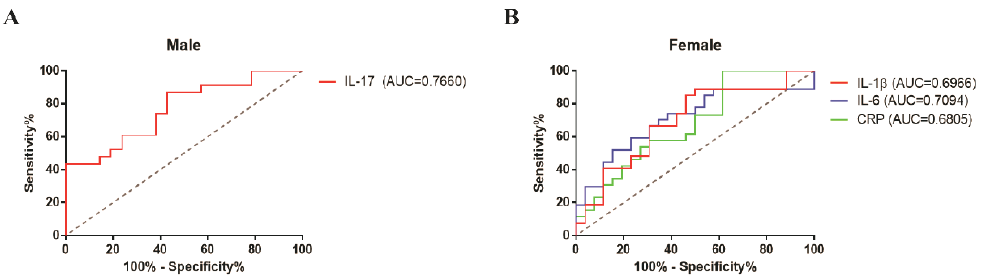
Figure 4. Receiver operating characteristic (ROC) analyses of IL-17 in the male group ( A ) and IL-1 β , IL-6, and CRP in the female group ( B ), indicating moderate diagnostic accuracy of each elevated inflammatory biomarker. AUC, area under the curve. Male (HC, n = 24; MDD, n = 23) and female (HC, n = 26; MDD, n = 27). The cutoff value was determined using Youden’s J statistic.